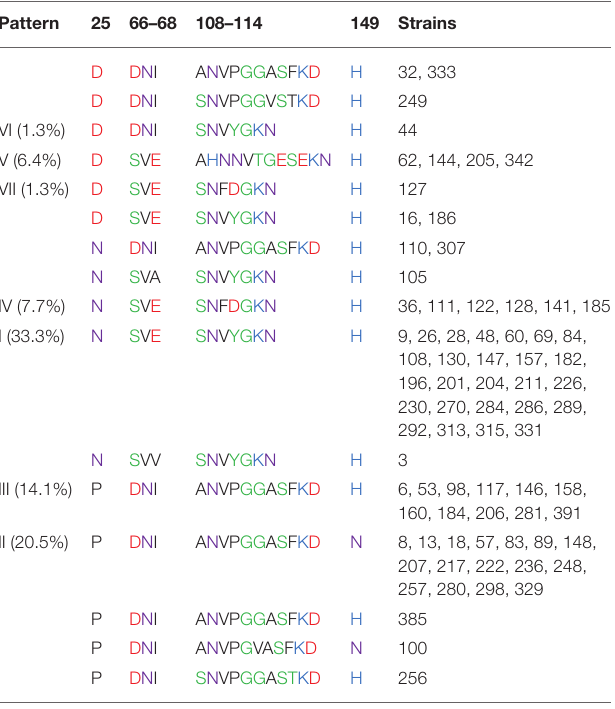
TABLE 3 | (A) Outer loop polymorphism patterns. Pattern